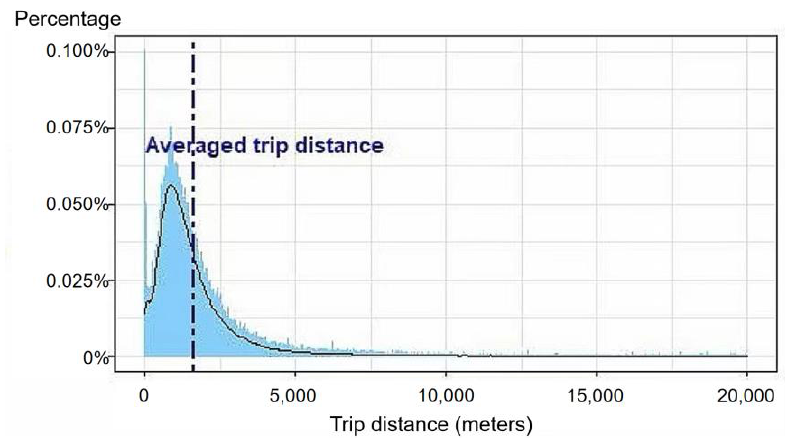
Figure 4. Average travel distance per shared bike .